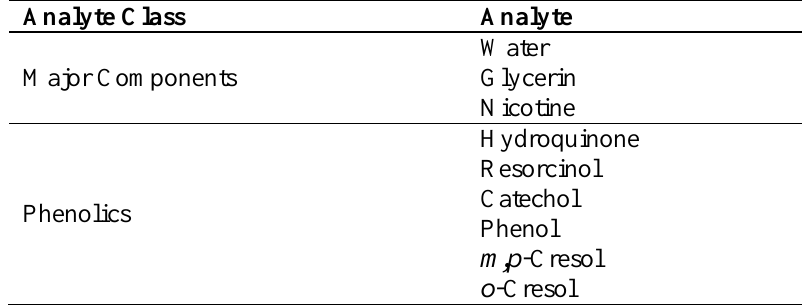
Table 1. A listing of the three classes of analytes—major components, phenolic and carbonyl and individual analytes measured in this